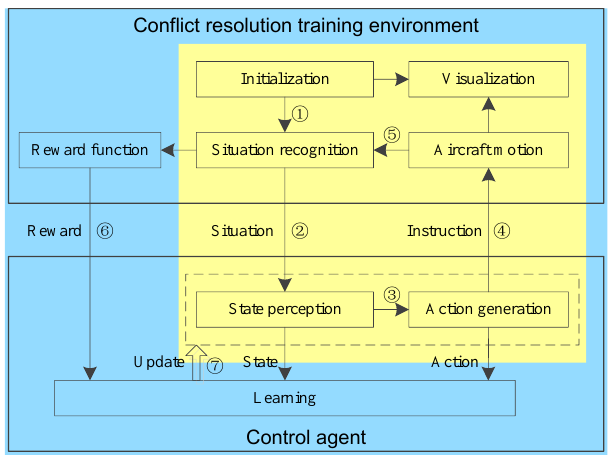
Figure 4. Conflict resolution agent training